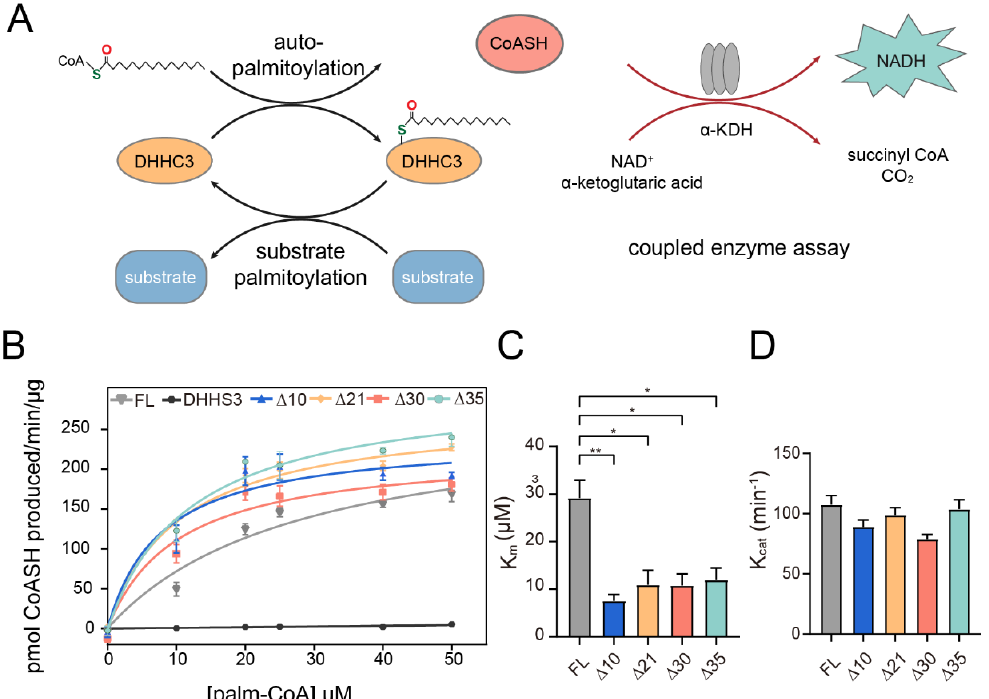
Figure 2. Functional characterization of full-length and truncated hDHHC3s. ( A ) Schematic illustration of Ping-Pang kinetic mechanism of DHHC3 mediated palmitoylation and its coupled enzyme assay. ( B ) The results from the coupled enzyme assay for full-length hDHHC3, inactive hDHHS3 and N-terminal truncated hDHHC3, respectively. Data were fitted into a Michaelis–Menten equation shown as mean ± SEM of 3 repeated measurements. ( C ) K m and ( D ) K cat values of full-length and truncated hDHHC3 determined from ( B ). Data are shown as mean ± SEM of 3 repeated measurements, and p -values were calculated using two-tailed Student’s t tests. *, p < 0.05; **, p <